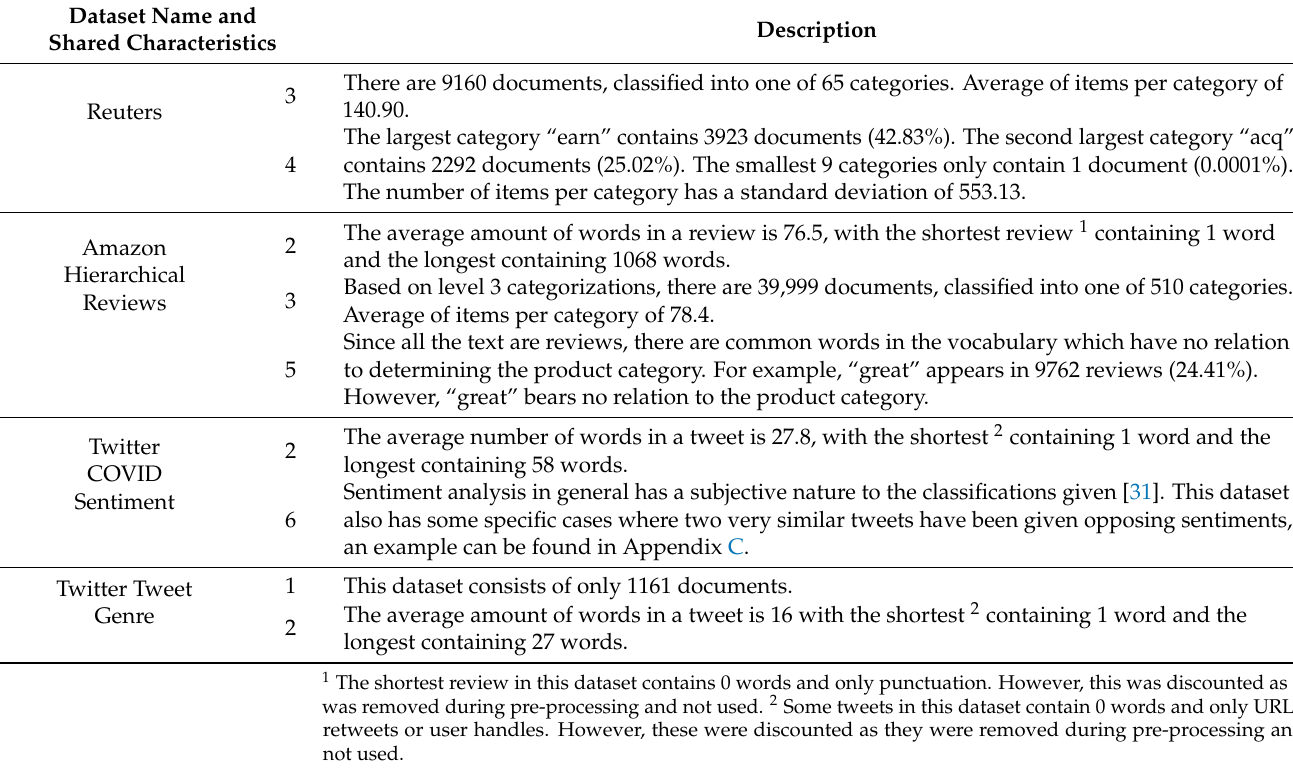
Table 1. Comparison of the datasets based on the complexity of their classification characteristics. The numbered characteristics refer to the list at the start of this